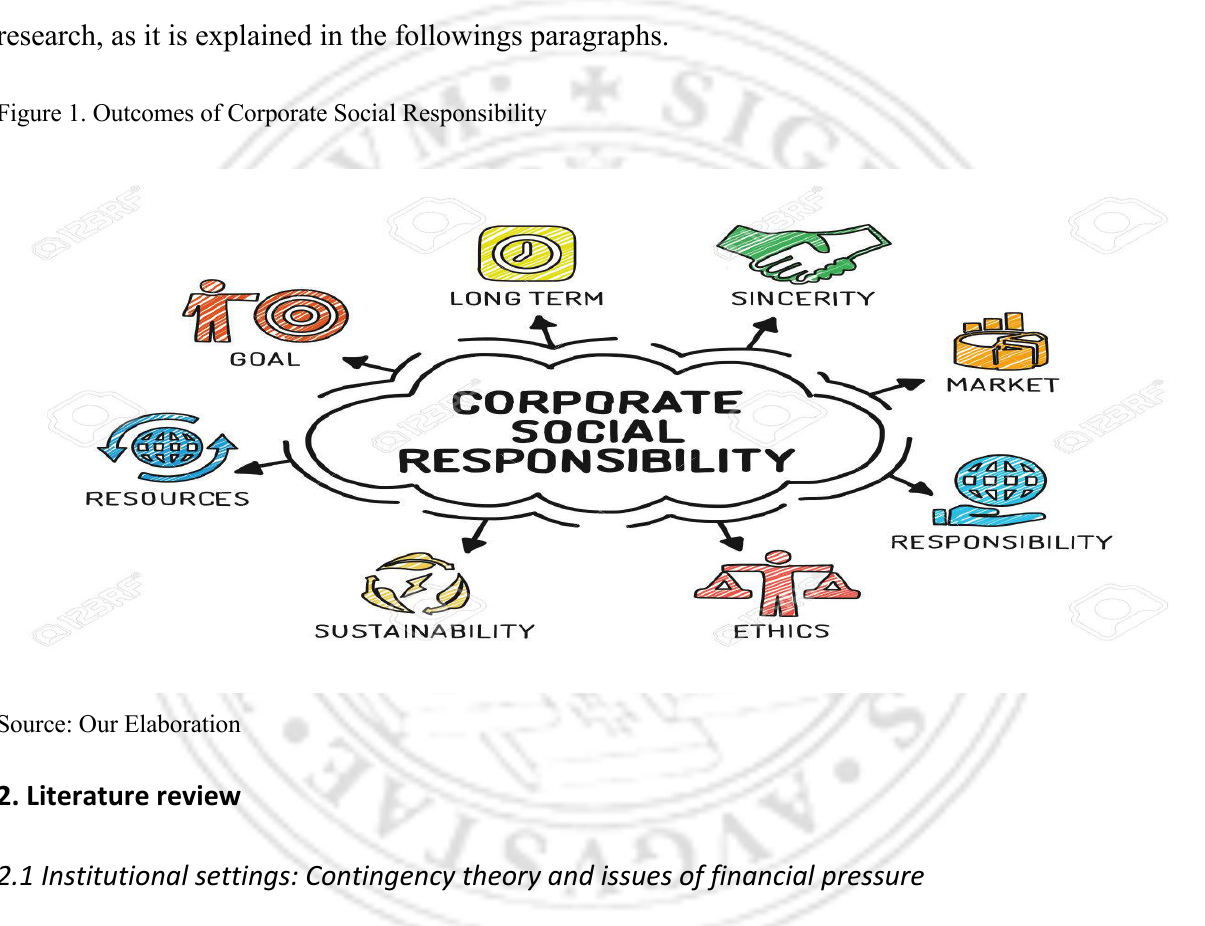
Figure 1. Outcomes of Corporate Social Responsibility